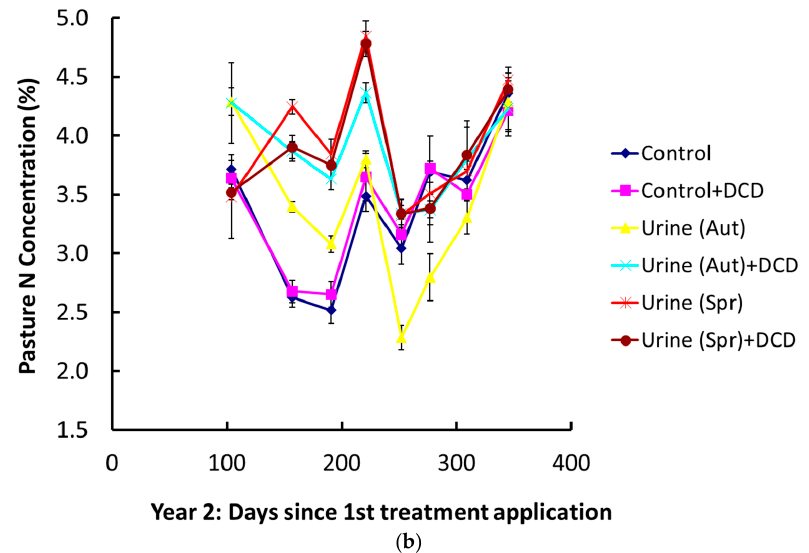
Figure 1. Mean pasture N concentrations for all treatments in: ( a ) Year 1 (2003/04 season); ( b ) year 2 (2004/05 Season). Experiment start date (Day 0) is 7 May in both years. Error bars represent ± 1 SEM, n = 4.